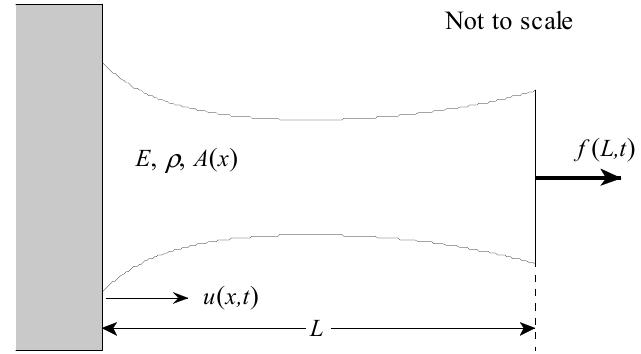
Figure 10. Fixed-free rod with a Gamma function change of area.